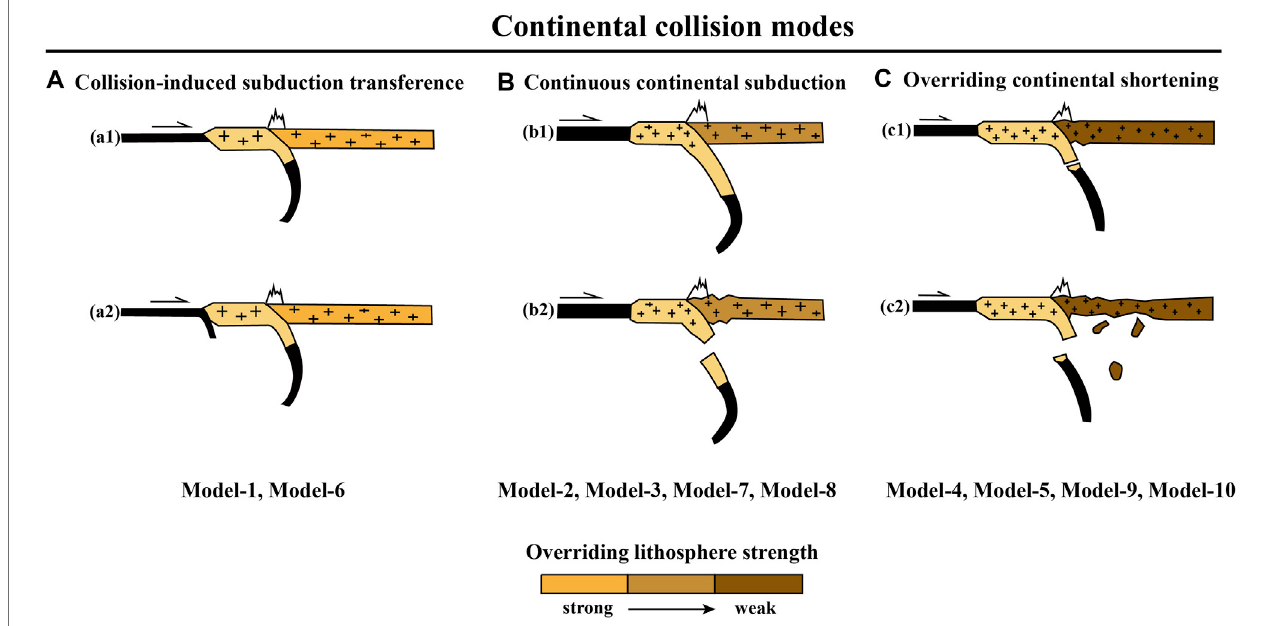
FIGURE 13 | Three collision modes dependent on the rheological strength of the overriding lithosphere. (A) Collision-induced subduction transference with a strong overriding plate. (B) Continuous continental deep subduction with intermediate strength of the overriding plate. (C) Overriding lithospheric shortening and delamination with a weak overriding